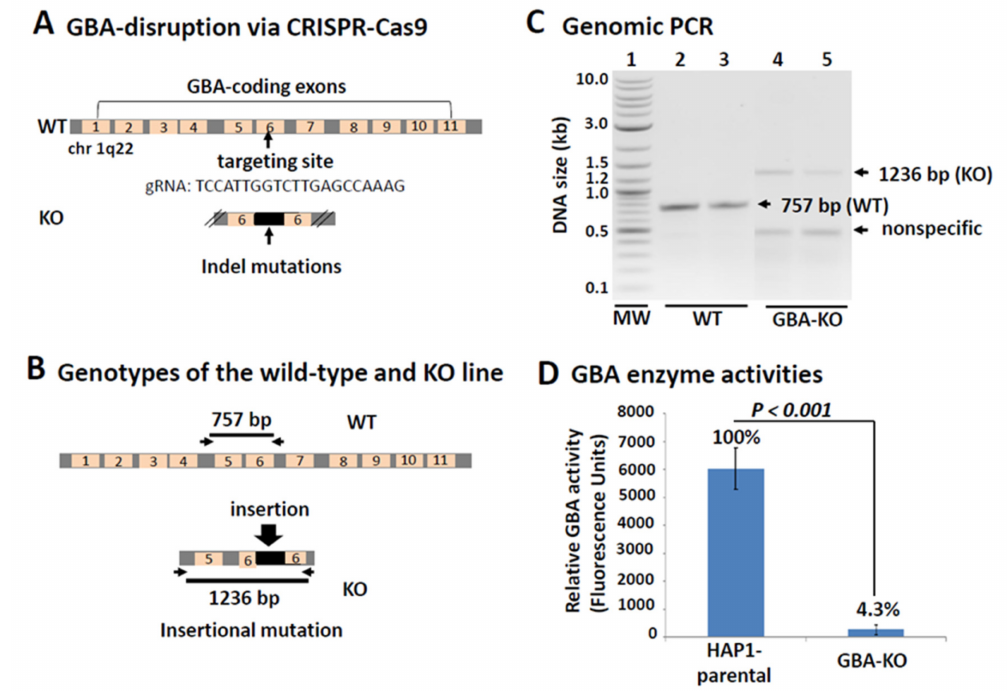
Figure 1. Schematic overview of the targeting strategy to knockout GBA in the human genome. ( A ) The human GBA gene is composed of 11 exons located on chromosome 1. The guide RNA (gRNA) of CRISPR-Cas9 was designed to target the coding region in Exon 6. Introns are shown in gray; exons are in yellow and are numbered. The arrow indicates the binding site of gRNA. ( B ) The locations of the PCR primers used for genotyping the HAP1 cells are indicated by arrows. This primer pair flanks the gRNA binding sites and will produce a 757 bp DNA in wild-type HAP1 and a 1236 bp DNA fragment in KO HAP1 due to a 479 bp insertion. ( C ) Genotyping analysis of the HAP1 parental and KO lines. Exon 6-specific primers amplified expected PCR products of 757 bp in the wild-type HAP1 parental line (lane 1–2) and 1236 bp in the KO HAP1 line. ( D ) A drastic reduction of GBA activity in the KO line as compared to those of wild-type